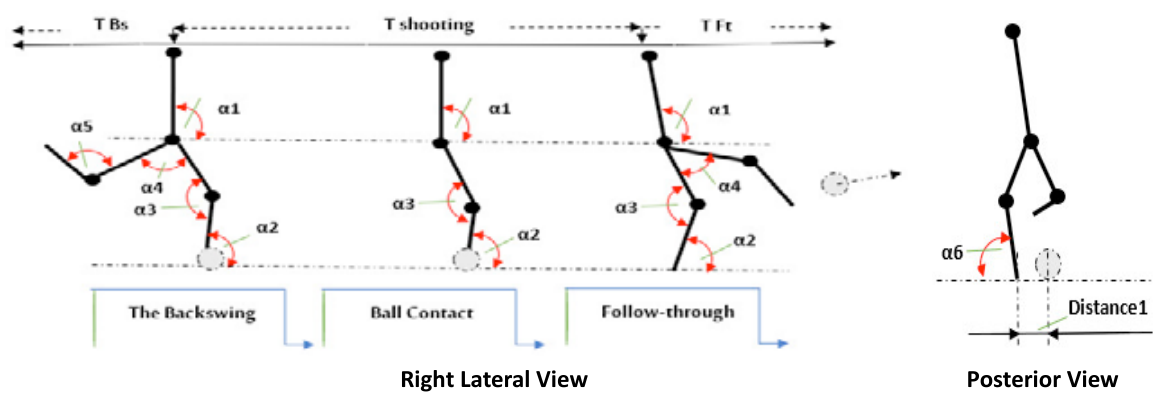
Figure 2. Spaces chosen for Accuracy penalty-kicking test.